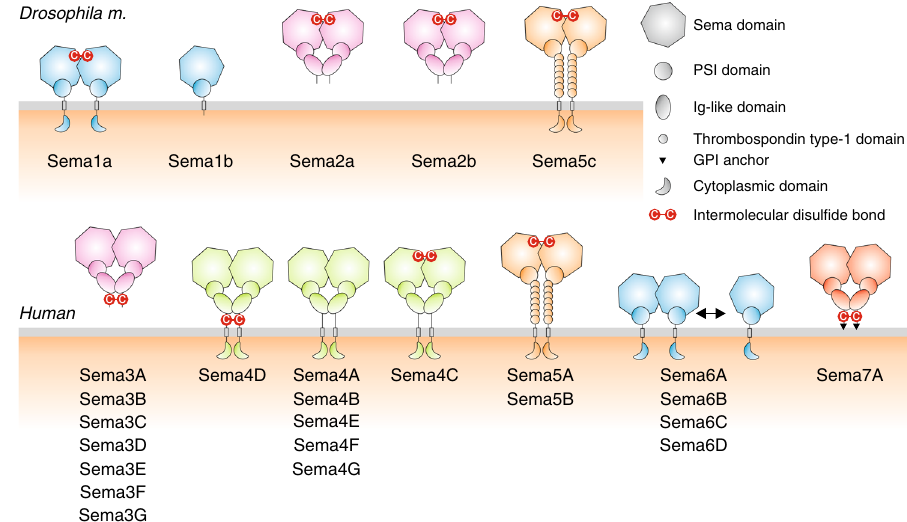
Fig. 6 Oligomeric state of fl y and human semaphorins. We found that the Drosophila Sema1a ectodomain and also full-length Sema2a and Sema2b are disul fi de-linked dimers, while the Sema1b ectodomain is monomeric. Our sequence analysis indicates that the cysteine involved in the sema-to-sema disul fi de bond is conserved in the class 5 semaphorins 5A, 5B and 5c, and in Sema4C. Sema3A and Sema4D have also been described as disul fi de-linked dimers with the interchain disul fi de bond located in a region followed by the Ig-like domain. This cysteine is highly conserved in all class 3 semaphorins, however, it is not conserved in the other class 4 semaphorins (Sema4A, 4B, 4E, 4F and 4G), in which the dimeric architecture is potentially stabilized by non-covalent interactions between the sema and Ig-like domains. It is not clear whether Sema7A is a non-covalent dimer or a disul fi de-linked dimer. The Sema6A ectodomain has been reported as a mixture of a monomer and a non-covalent dimer in solution 6,7 . Remarkably, there is an obvious similarity with their structural homologues, Drosophila class 1